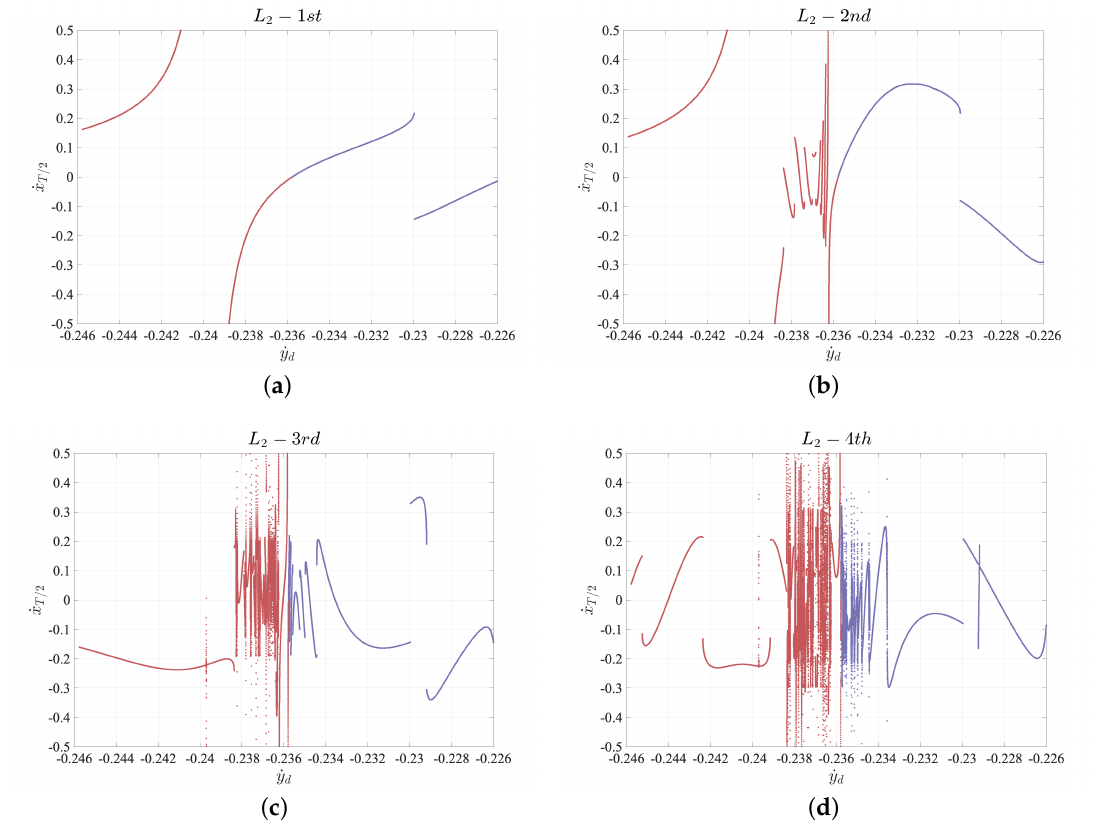
Figure 14. Curves of the velocity along the x -direction when the trajectory intersects with the x -axis for the first ( a ), second ( b ), third ( c ), and fourth ( d ) time. The abscissa is the initial velocity along the y -axis. The reference orbit is a planar Lyapunov orbit around the L 2 point with a Jacobi constant of C = 2.99747681824366. The purple dots indicate a positive ∆ v and the red points indicate a negative ∆ v